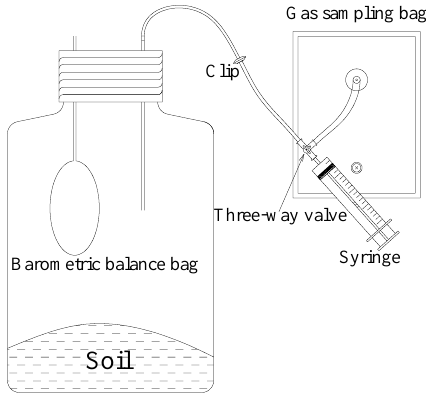
Figure 1. Diagram of the incubation bottle with pressure balance apparatus.